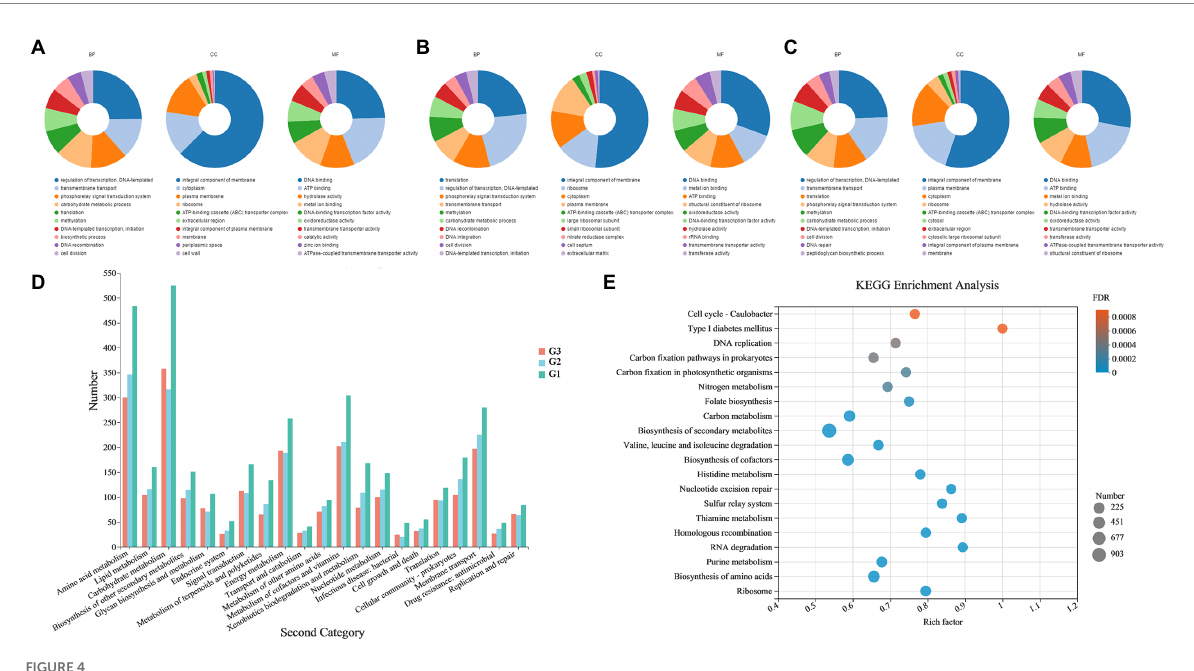
FIGURE 4 GO and KEGG functional annotations of Streptomyces sp. G1 T , Streptomyces sp. G2 T and Streptomyces sp. G3 T . (A–C) GO annotations of the three actinomyces with straw-decomposition ability; (D) Comparison of KEGG functional categories of the strains G1–G3; (E) KEGG enrichment bubble plot comparing Streptomyces sp. G1–G3. Vertical coordinate indicates the name of the pathways. Horizontal coordinate represents the enrichment rate. The dots’ size represents the number of genes in the pathway, and the color of the dots indicates the significance of the enrichment. Abbreviations: BP, biological process; CC, cellular component; MF, molecular function.